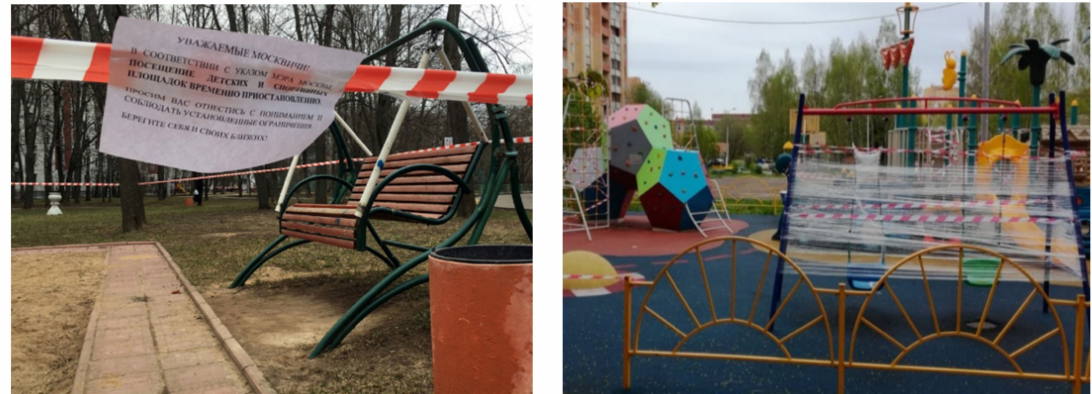
Figure 12. COVID-19 restrictions for use of playgrounds and sport